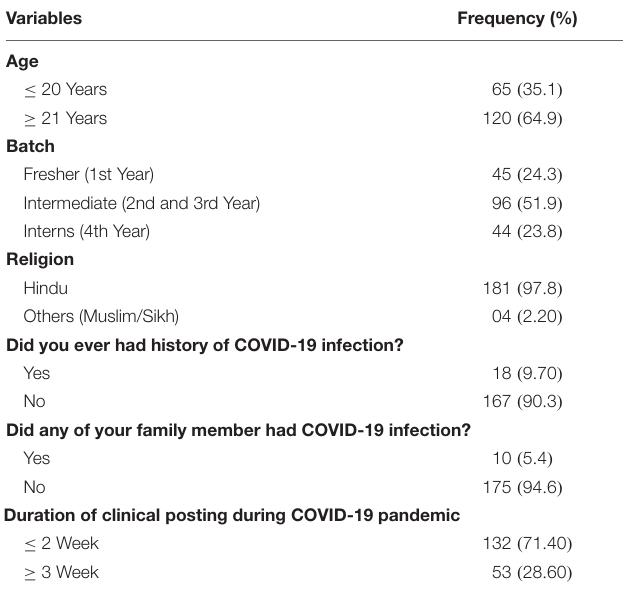
TABLE 1 | Frequency and percentage distribution of demographic